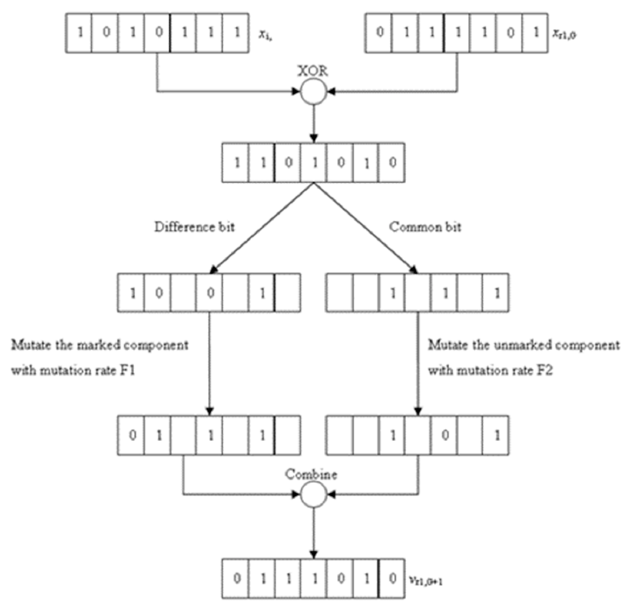
Figure 2. Modified binary mutation operator [15].